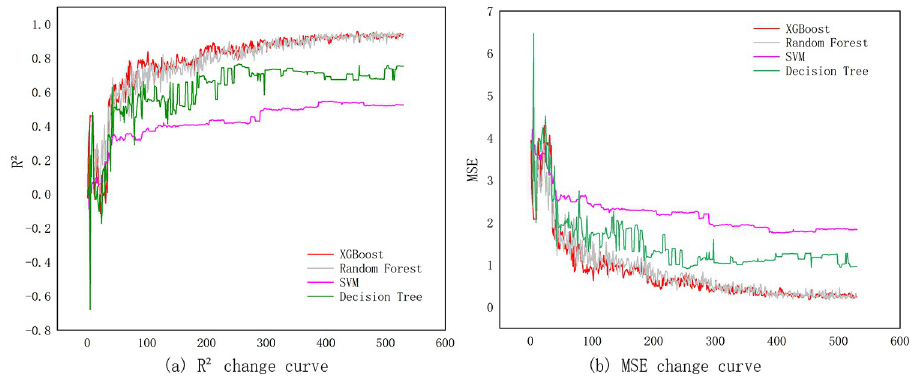
Fig 3. The four-model training learning